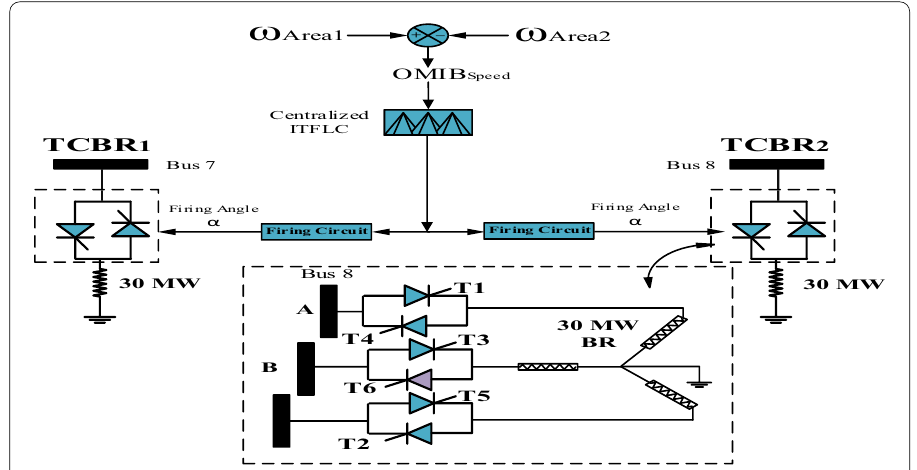
Fig. 2 Detail depiction for suggested dynamic braking